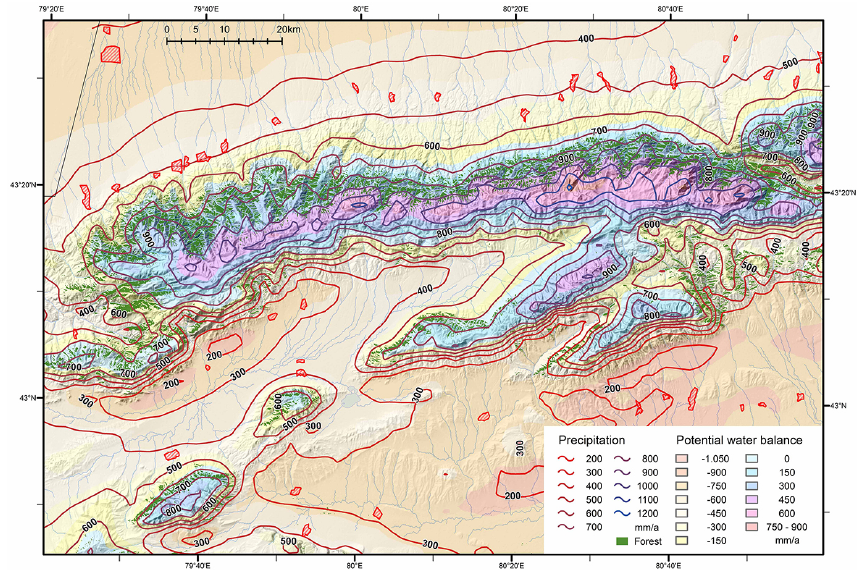
Figure 8. Distribution of AFA in relation to the hydrological climatic environment.